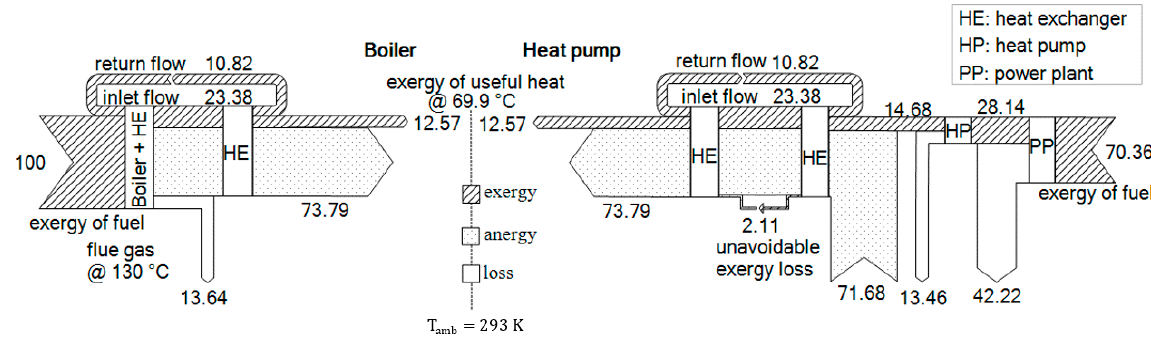
Figure 9. Sankey—comparison of heat supply for boiler and HP.